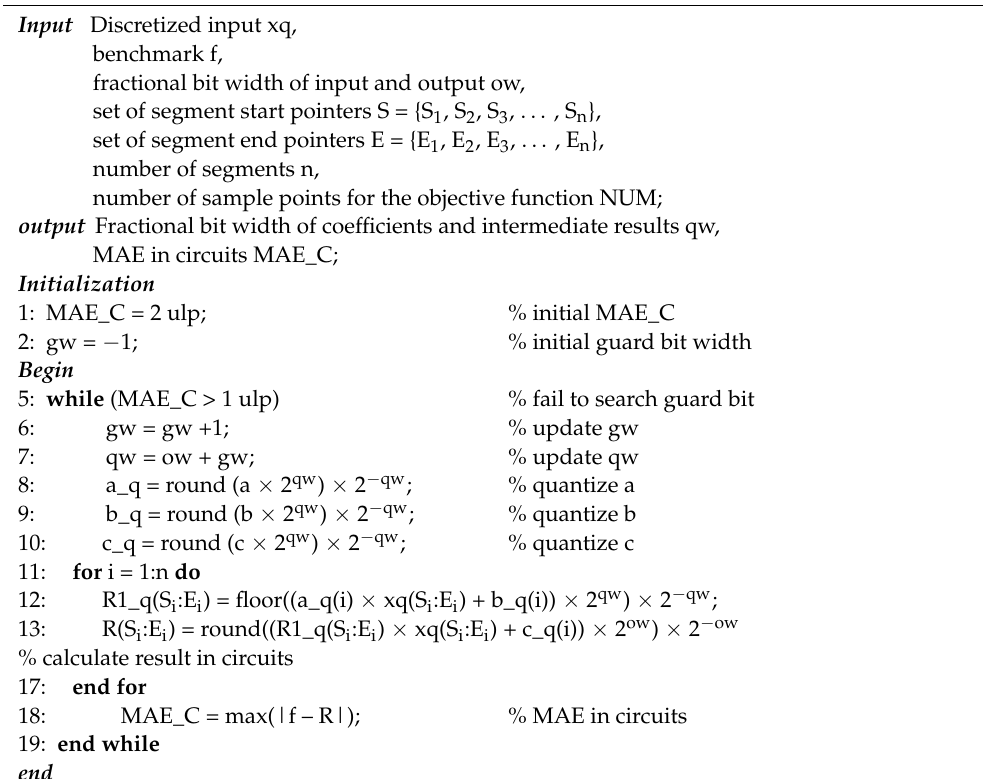
Algorithm 1: A novel quantizer